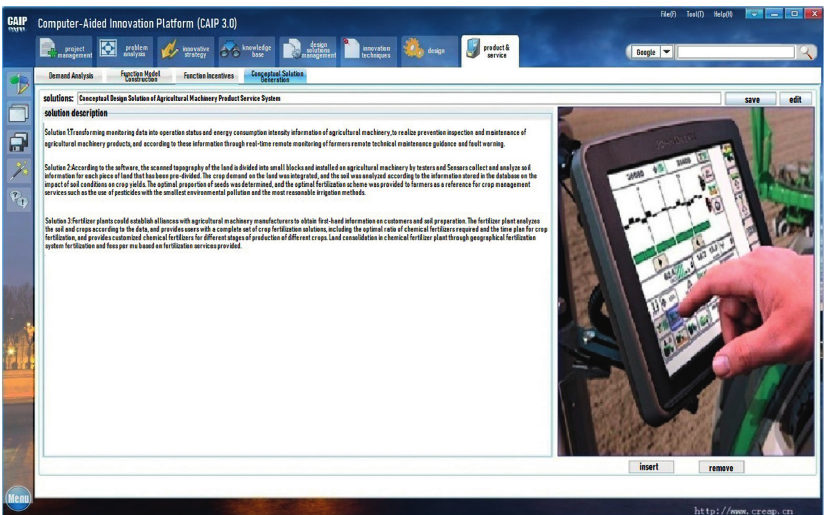
Figure 7: Design solutions submodule of the agricultural machinery PSS based on CAIP